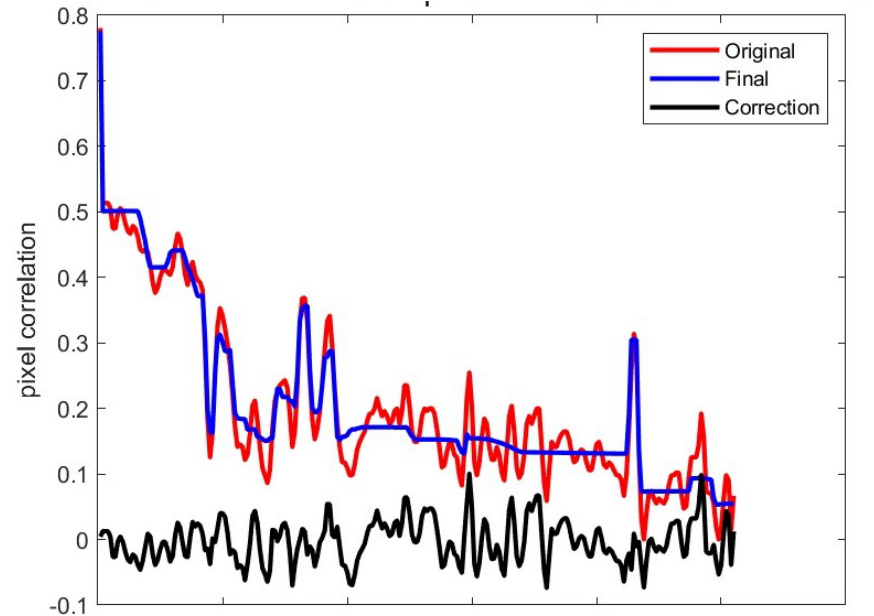
Figure 13. Pixel- correlation